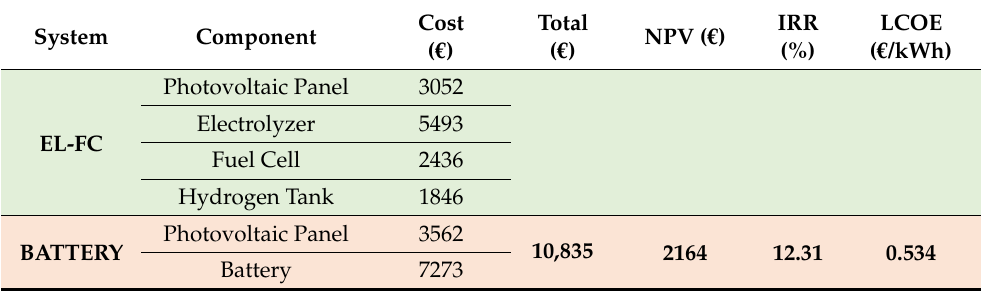
Table 3. Equipment investment and economic parameters for both systems: the electrolyzer–fuel cell system without a battery and the conventional system (photovoltaic panel with battery).